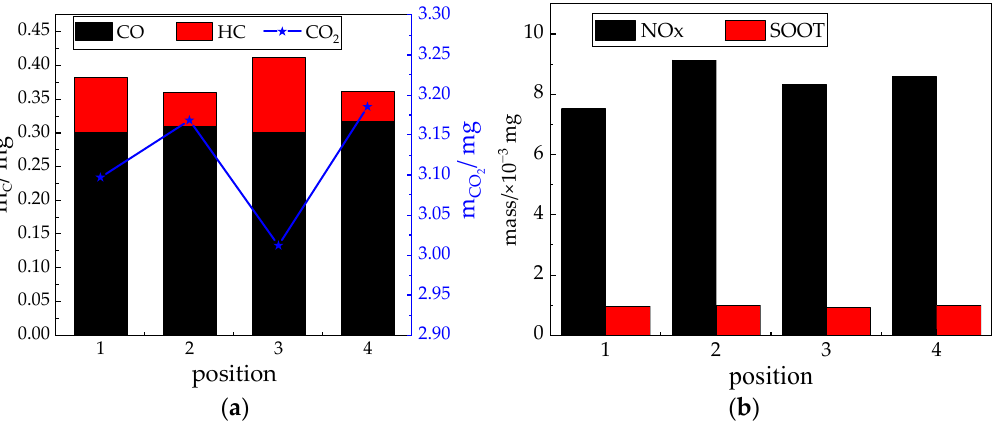
Figure 15. Comparison of final pollutants discharged into the atmosphere at different positions: ( a ) compound of carbon, ( b ) nitrides and soot.